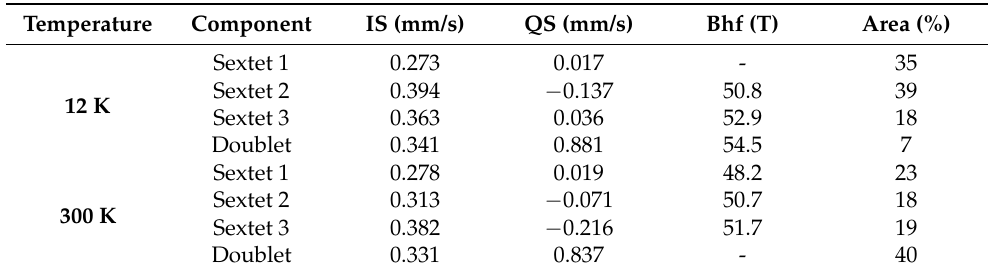
Table 2. Hyperfine parameters data of the Mössbauer spectra for the catalyst at low temperature (12 K) and at room temperature (300